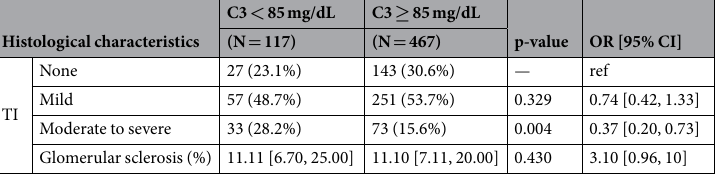
Table 2. Pathological data of the patients at the time of renal biopsy. TI: Tubulointerstitial